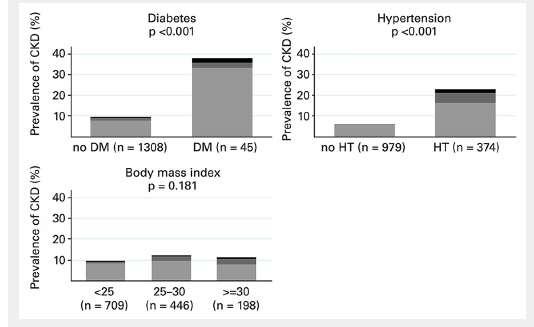
Prevalence of moderate, high and very high risk categories using the CKD KDIGO(2012) classification, by diabetes (panel a), hypertension (panel b), and BMI categories (panel c). CKD = chronic kidney disease; DM = diabetes mellitus; KDIGO = Kidney Disease – Improving Global Outcomes; HT = arterial